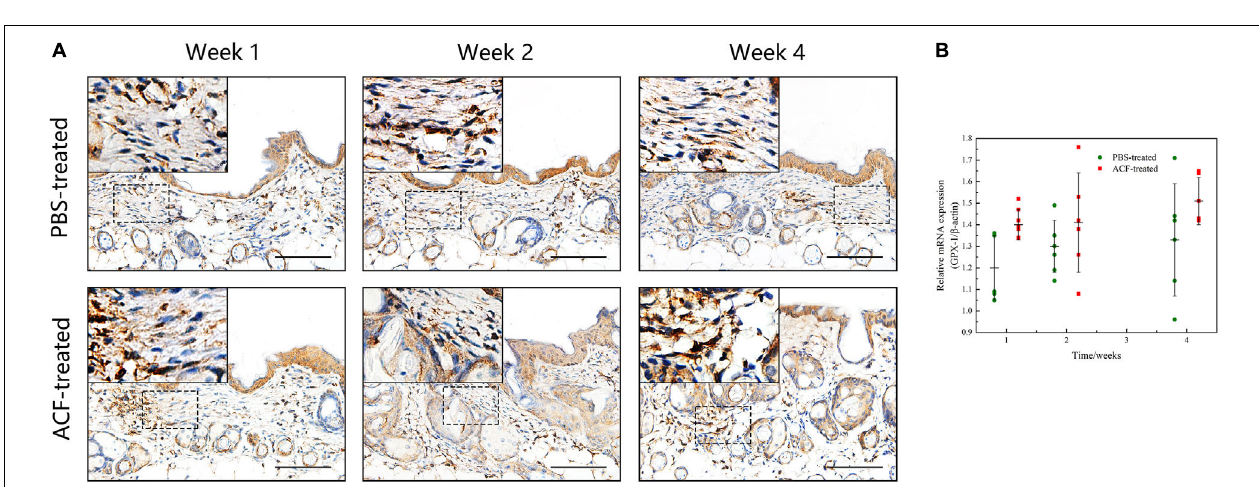
FIGURE 13 | The expression of catalase of mouse skin samples of ACF-treated group and control group. (A) The expression of antioxidant enzyme catalase was detected in both the ACF-treated and control groups at each time point. (B) Quantitative reverse transcription PCR analysis of the catalase expression in the dermis of both groups. The expression of catalase was higher in the ACF-treated group than in the control group at all time points. P (week 1) = 4.278E-04, F (week 1) = 0.639; P (week 2) = 9.229E-05, F (week 2) = 0.600; P (week 4) = 6.596E-07, F (week 4) = 0.527. Scale bar = 100 µ m.